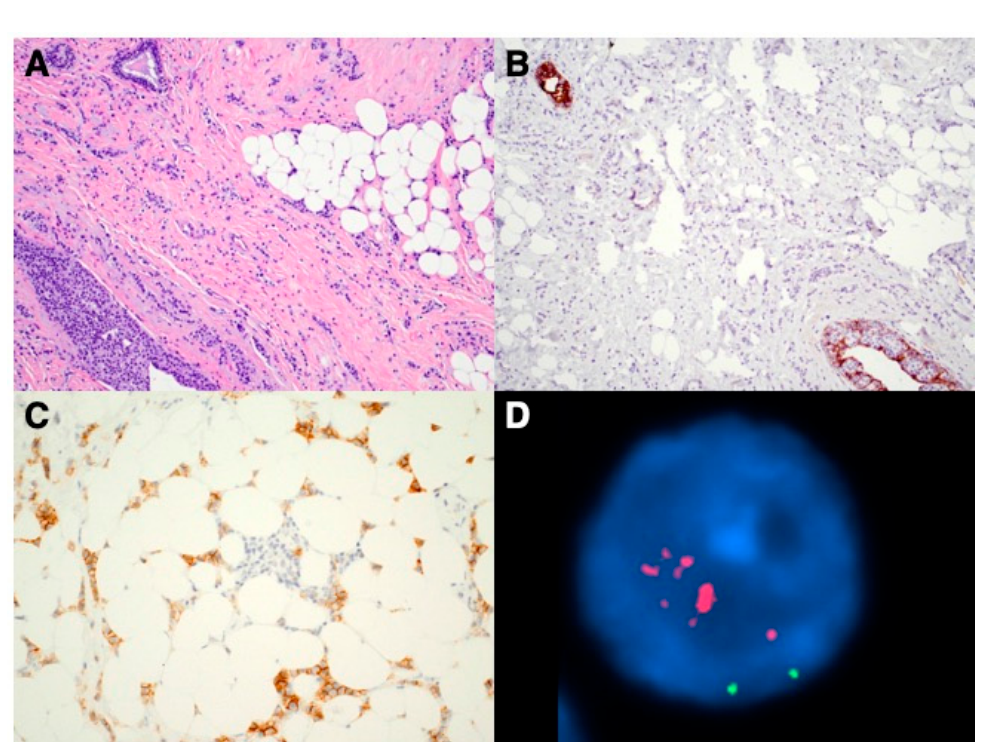
HER2/CEP17 ratio of 6.61 and average HER2 gene copy number/cell of 11.1. The patient underwent a left breast partial mastectomy and final resection pathology results con- firmed to be a 2.5 cm cILC with repeat HER2 IHC and FISH were both positive. After the surgery, the patient received chemotherapy, trastuzumab and hormonal therapy, and